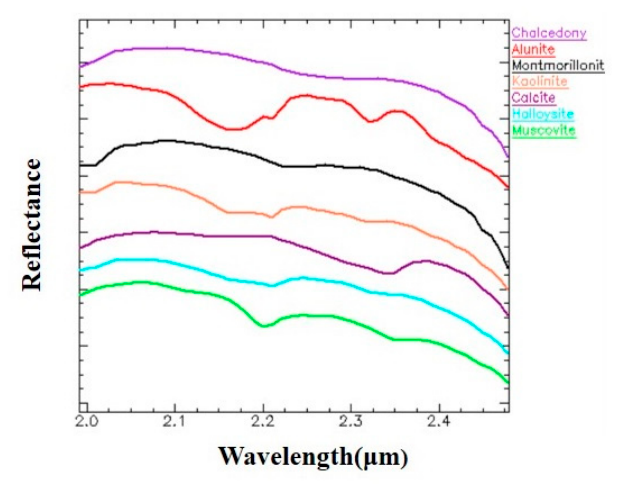
Figure 7. Reference spectra of various minerals. Table 3. Identification accuracies of different identification methods on the Nevada dataset.